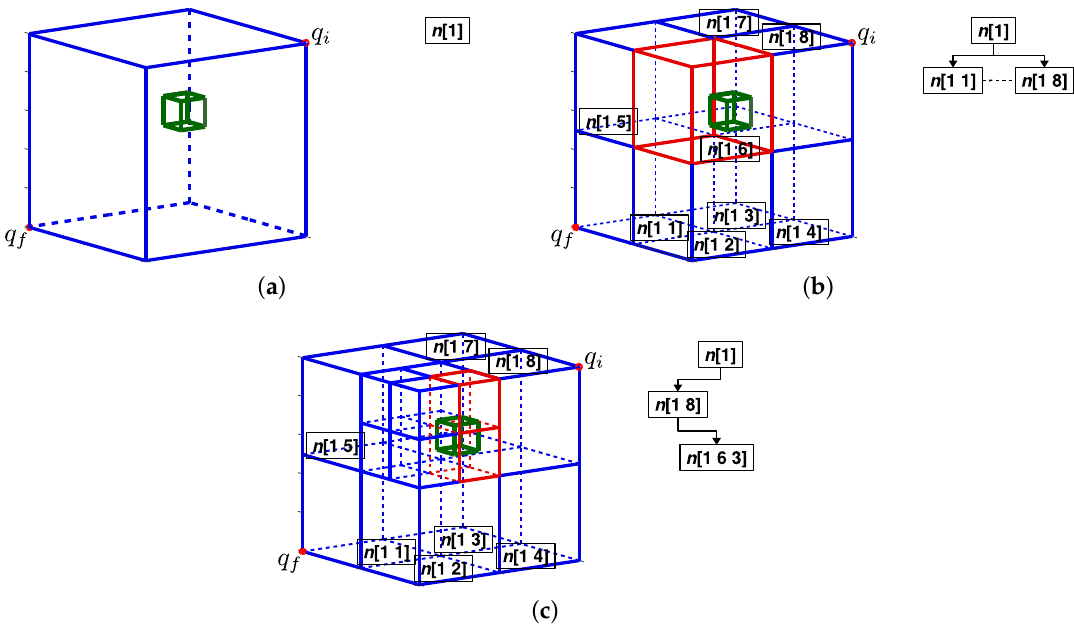
Figure 7. Recursive rewarding MACD ( RR-MACD ) start process example. ( a ) Complete